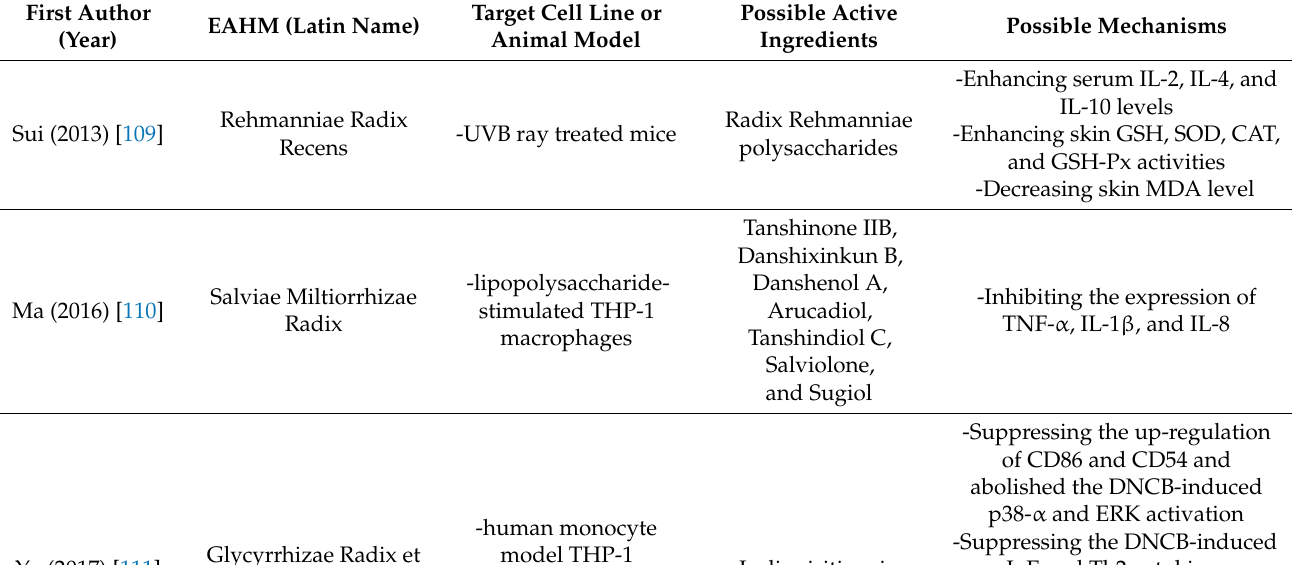
Table 7. Potential mechanism of core herbs included in this